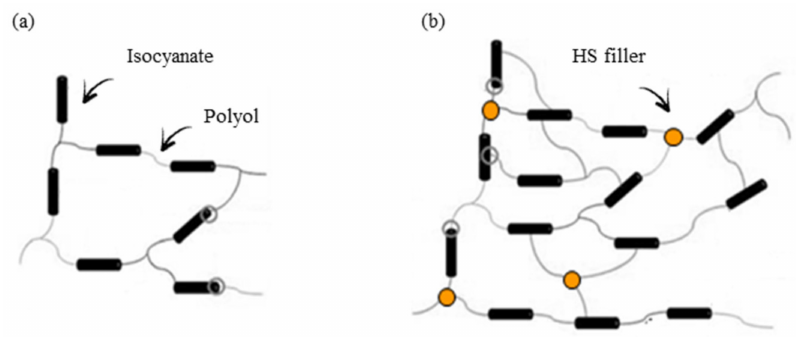
Figure 5. Crosslinking structure of ( a ) neat PUR foams and ( b ) PUR foams containing HS fillers.